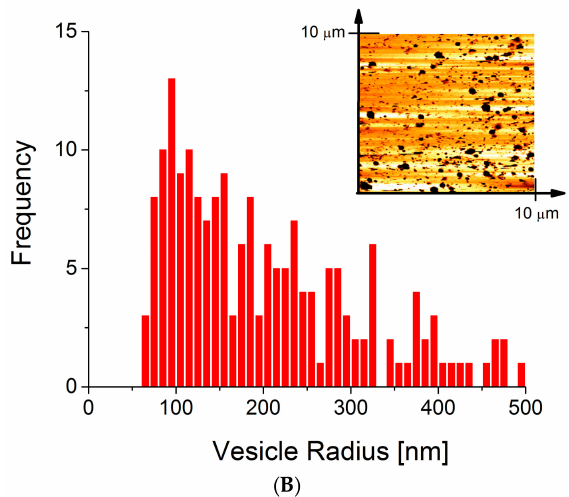
Figure 6. ( A ) Schematic illustration of atomic force microscopy; ( B ) The size distribution of EVs derived from HPC-4 cell line, obtained by the analysis of scanned topography image